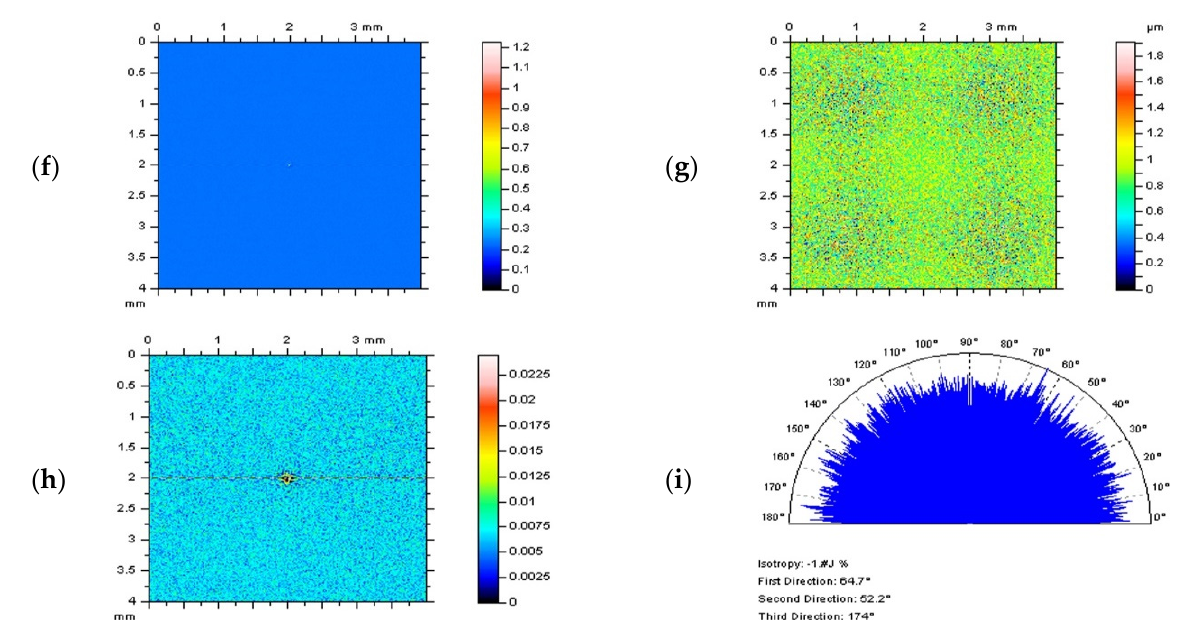
Figure 12. Contour map plot of the milled surface after a high-frequency errors reduction by a DMF method ( a ) with material ratio curve ( b ) and selected surface topography parameters ( c ) correspondingly, the S-surface received by application of DMF approach with cut-off = 0.025 mm ( d ), its PSD ( e ) and ACF ( f ), results of thresholding (0.13–99.87%) of S-surface ( g ) and ACF ( h ), the texture direction graph ( i ) defined for thresholded S-surface presented in ( g ) subsection of the figure.